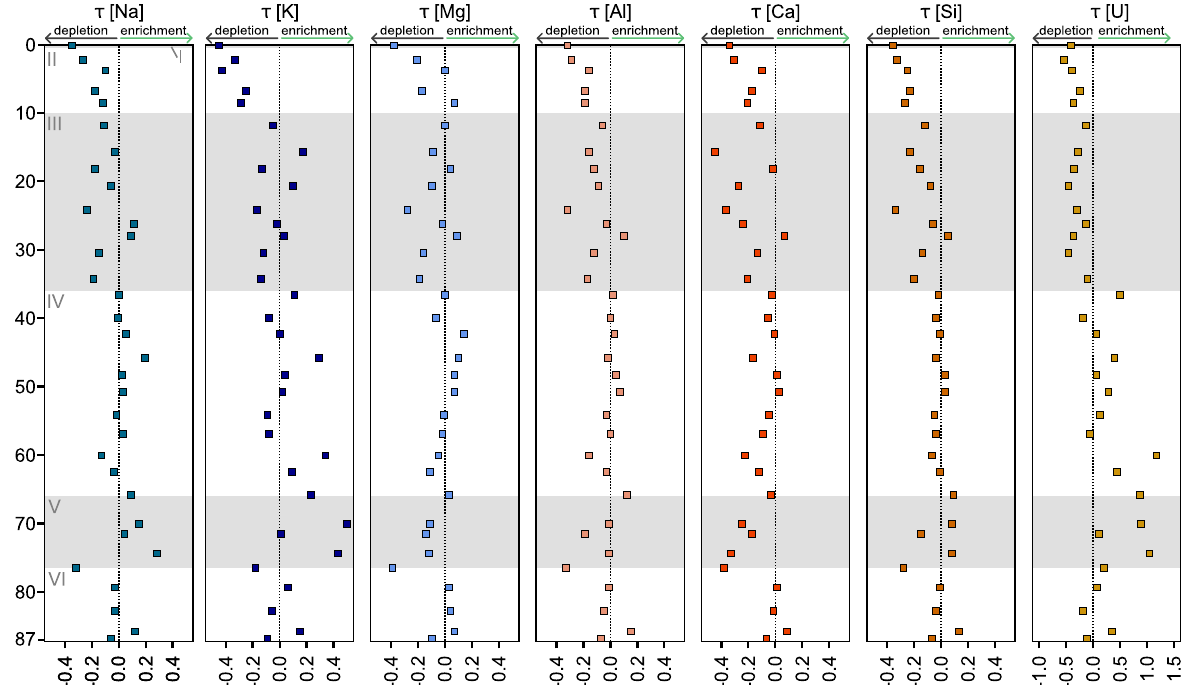
Figure 6. Elemental mass transfer coefficient (τ) calculated relative to four averaged bedrock samples. Values < 0 indicate depletion of an element whereas values > 0 indicate enrichment relative to bedrock. Dotted reference line indicates zero mass loss. Grey and white shades denote the core zones (I–VI) described in the